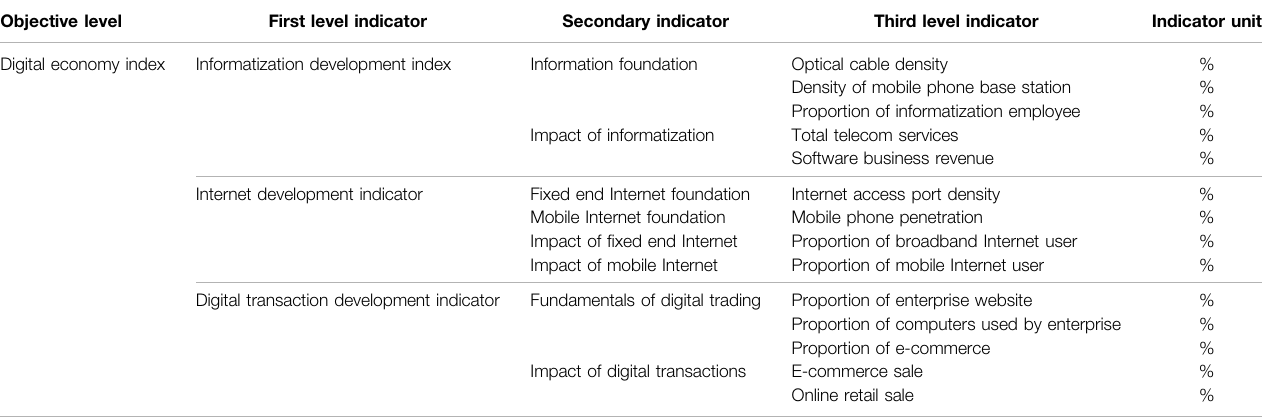
TABLE 1 | Digital economy index evaluation index